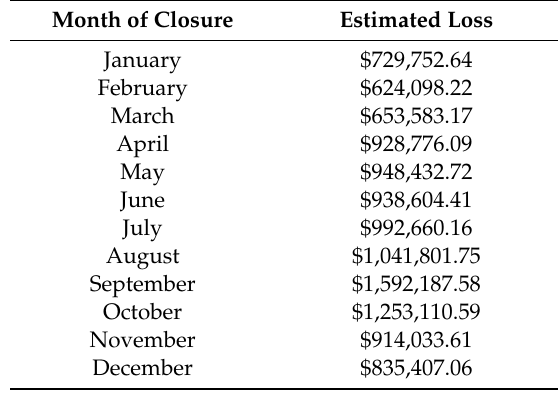
Table 4. Consumer surplus lost in closure scenarios for 12 months (2018